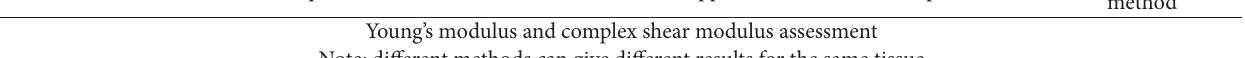
Table 2: Methods to assess physical characteristics of matrices and tissues, used in stem cell studies.